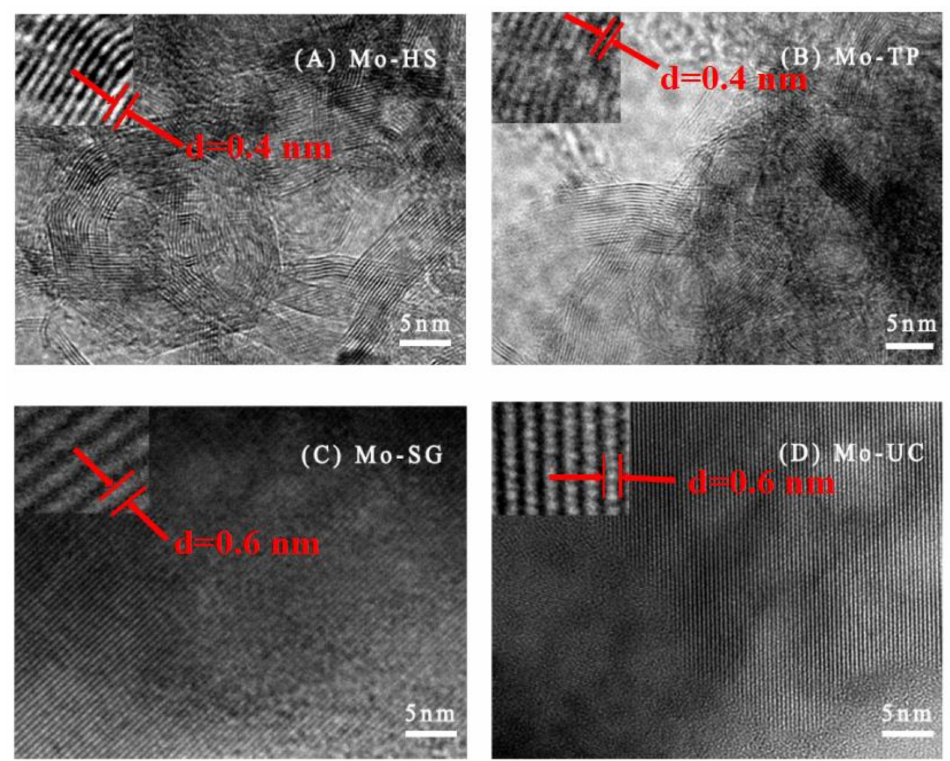
Figure 3. TEM images of Mo/ZnAl-LDH catalysts: ( A ) Mo-hydrothermal-synthesis (HS); ( B ) Mo-traditional-precipitation (TP); ( C ) Mo-sol-gel (SG); and ( D ) Mo-urea-co-precipitation (UC).